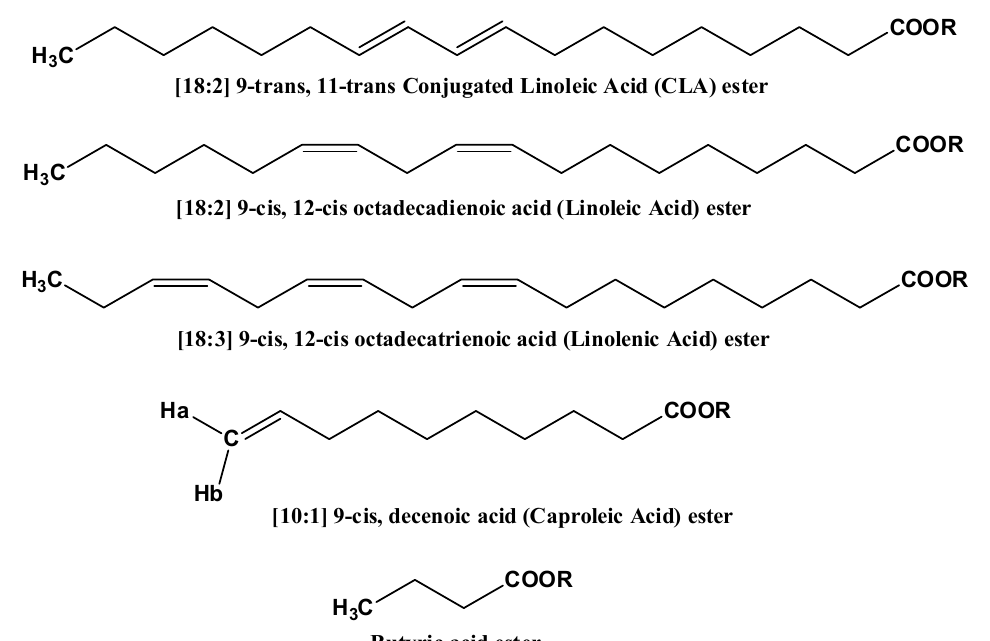
Scheme 1. Chemical structures of the compounds investigated in the present metabolomics study.